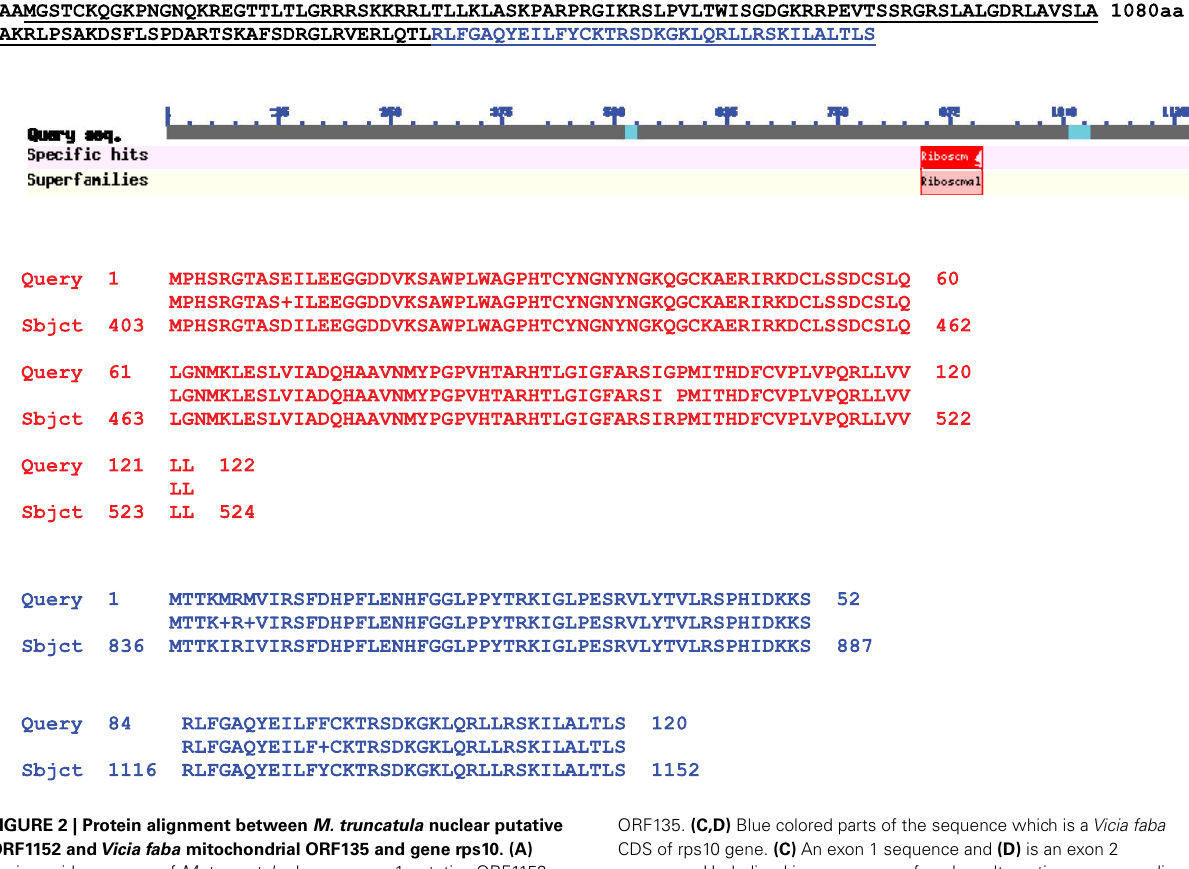
FIGURE 2 | Protein alignment between M. truncatula nuclear putative ORF1152 and Vicia faba mitochondrial ORF135 and gene rps10. (A) Amino acid sequence of M. truncatula chromosome 1 putative ORF1152 (NCBI BLAST). (B) Red colored sequence which is a part of mitochondrial